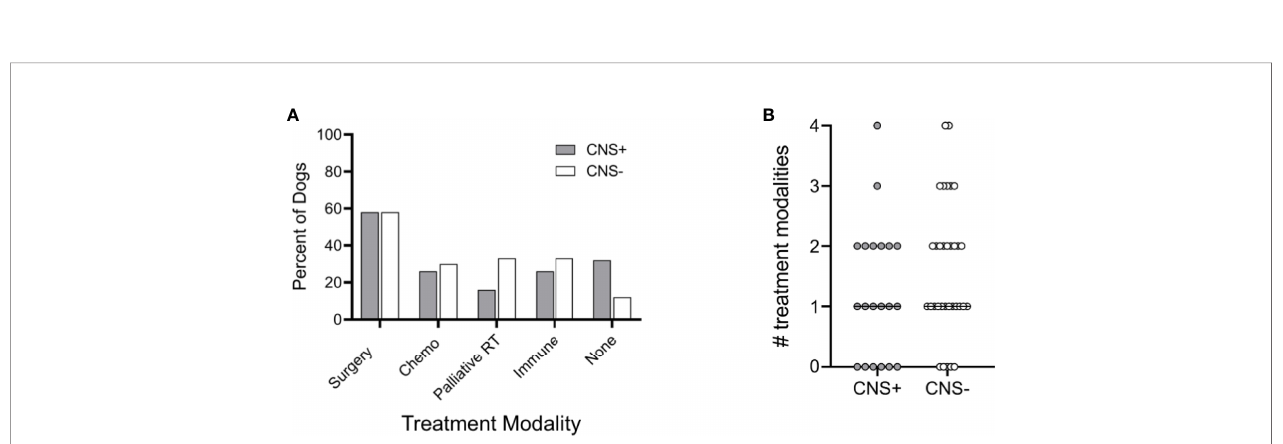
FIGURE 5 | Treatment modalities utilized in dogs with melanoma. (A) Percentage of dogs treated with each modality, either alone or in combination, was similar between dogs that developed CNS metastasis and those that did not. (B) The median number of treatment modalities was not signi fi cantly different between groups (p=0.263). Comparison based on Wilcoxon-Mann-Whitney rank sum test. Chemo, cytotoxic chemotherapy; Palliative RT, palliative radiation therapy; Immune, immunotherapy (i.e., melanoma